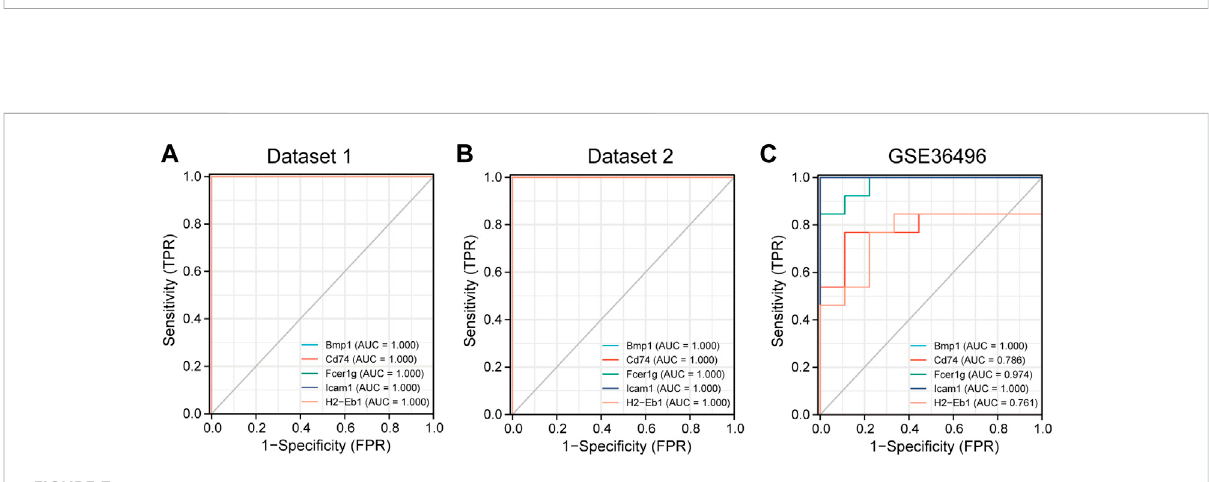
FIGURE 7 Thereceiveroperatingcharacteristic(ROC)curveofthe fi vehubgenesinthreedatasets. (A) Thediagnosisvalueofthe5hubgenesindataset1. (B) The diagnosis value of the 5 hub genes in dataset 2. (C) The diagnosis value of the 5 hub genes in dataset GSE36496. AUC: area under the curve.